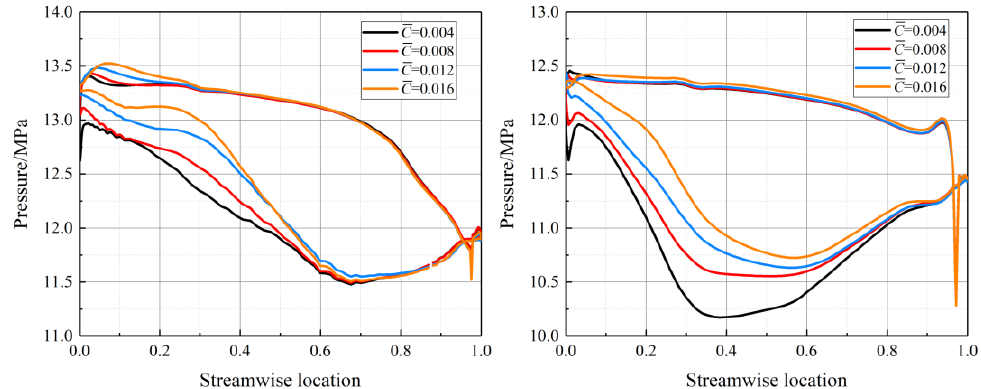
Figure 8. The static pressure distributions under different seal clearance: (left: 1% blade height of rotor; right: 99% blade height of stator2).